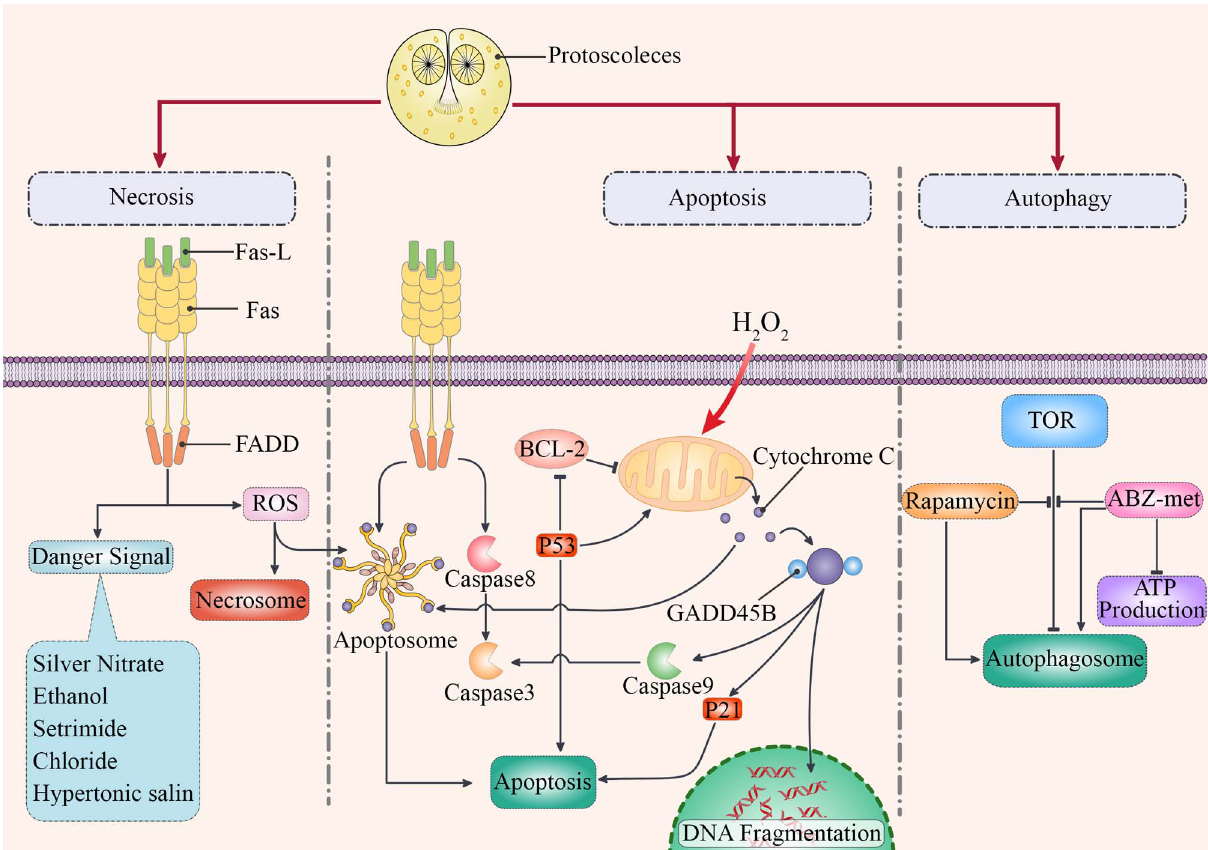
Figure 1. A summary of the potential mechanisms of cell death induced by Echinococcus spp. larval stage. The main molecules involved in cell death are shown, and the three main paths are shown with bold arrows. Directions for stimulation of necrosis, apoptosis and autophagy are shown. In the process of cell death caused by Echinococcus spp., apoptosis plays an important role in the cytolysis of the involved tissues. They can activate both extrinsic and intrinsic pathways. For example, some of them motivate mitochondria to release cytochrome C and P53, resulting in the formation of apoptosomes and activation of